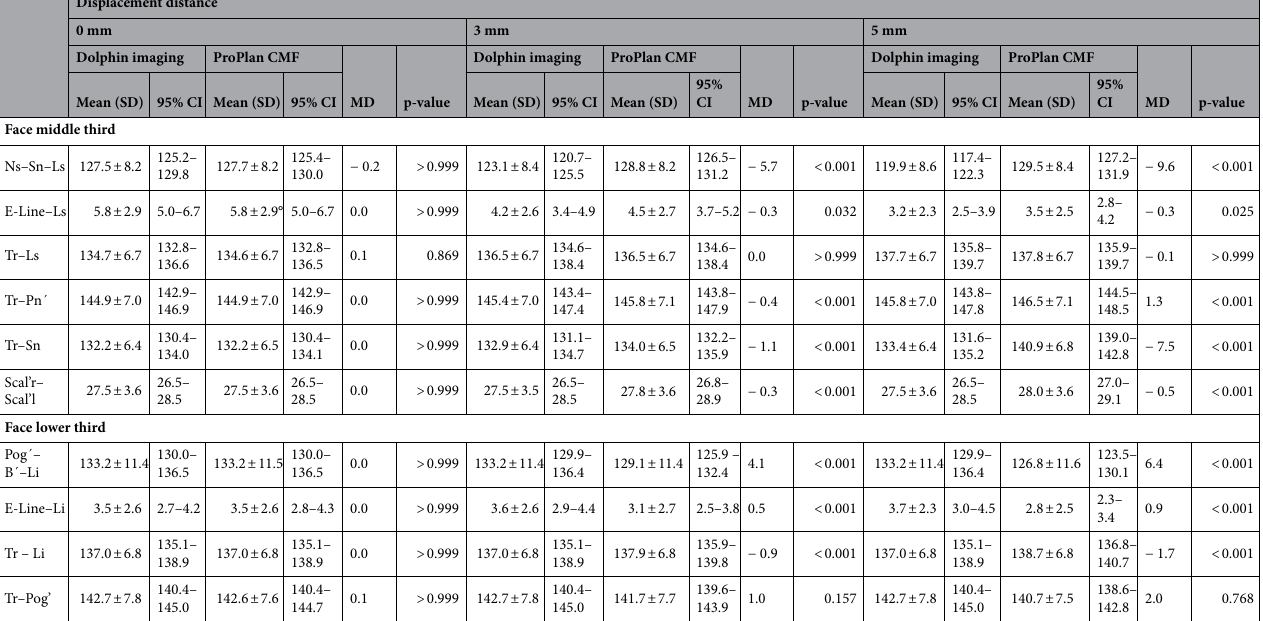
Table 4. Mean values, SDs and 95% confidence intervals of the angular and linear changes in the middle and lower third of the face after maxillary surgery simulation with the corresponding p values of the comparison between the outcome of the surgical planning programs Dolphin and ProPlan depending on the different maxillary advancement displacement distances. SD standard deviation, CI confidence interval, MD mean difference.